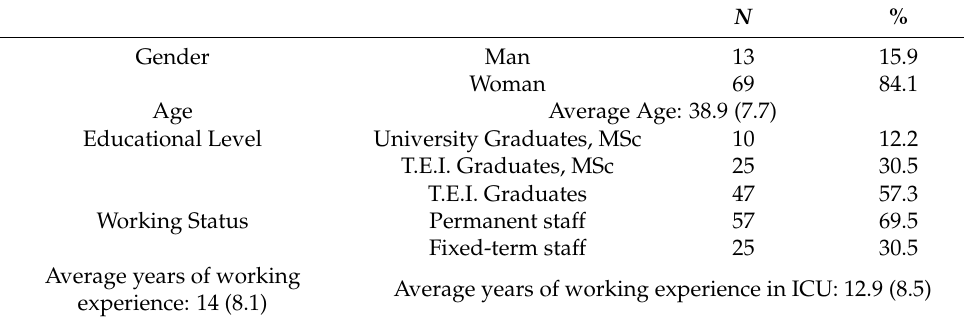
Table 2. Demographic characteristics of nurses in